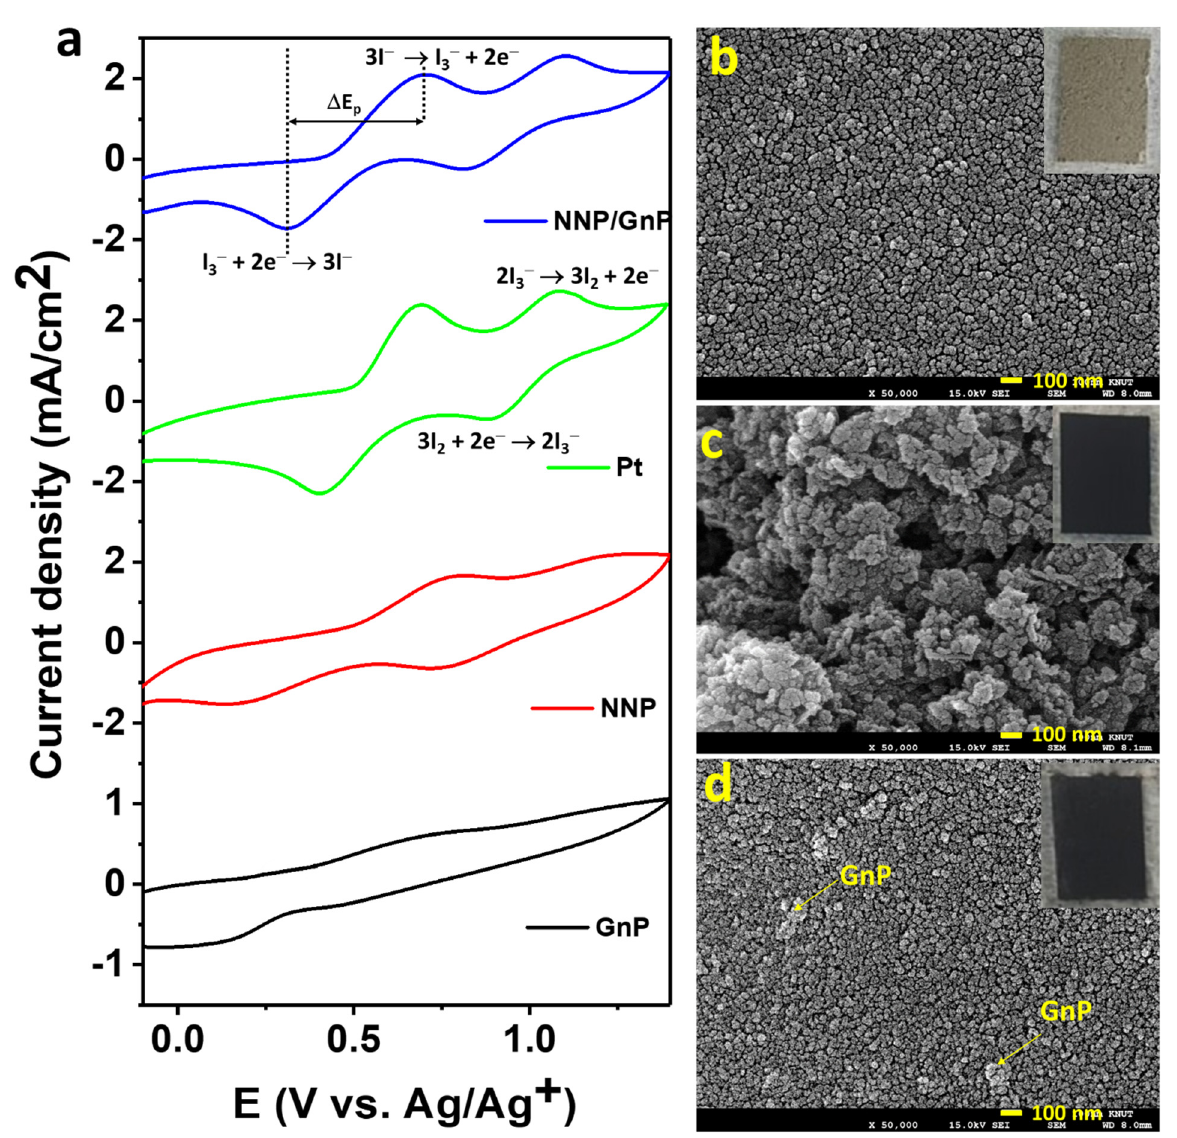
Figure 4. ( a ) CVs of the I - /I 3- electrolyte at different CEs (scan rate: 100 mV/s). To-view FE-SEM images of ( b ) NNP, ( c ) GnP, and ( d ) NNP/GnP CEs. Insets of ( b – d ) show the digital photographs of NNP-, GnP-, and NNP/GnP-CEs, respectively. Table 1. Electrochemical parameters of the various CEs.